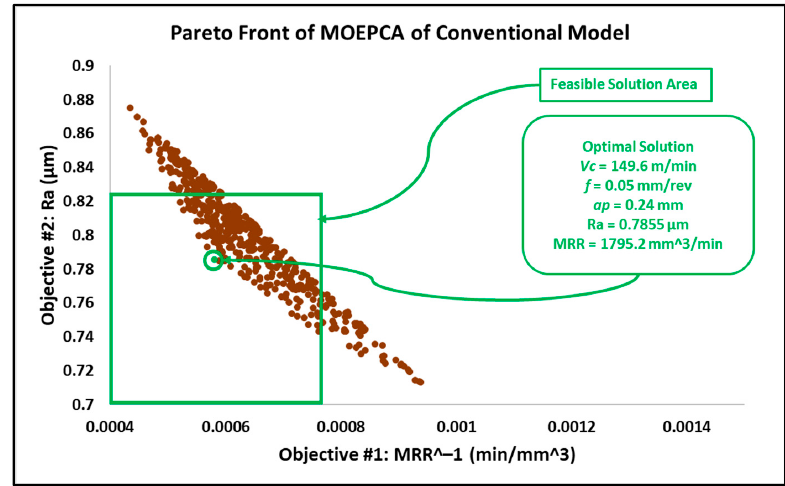
Figure 13. Pareto front plot of MOEPCA solution of the conventional model.